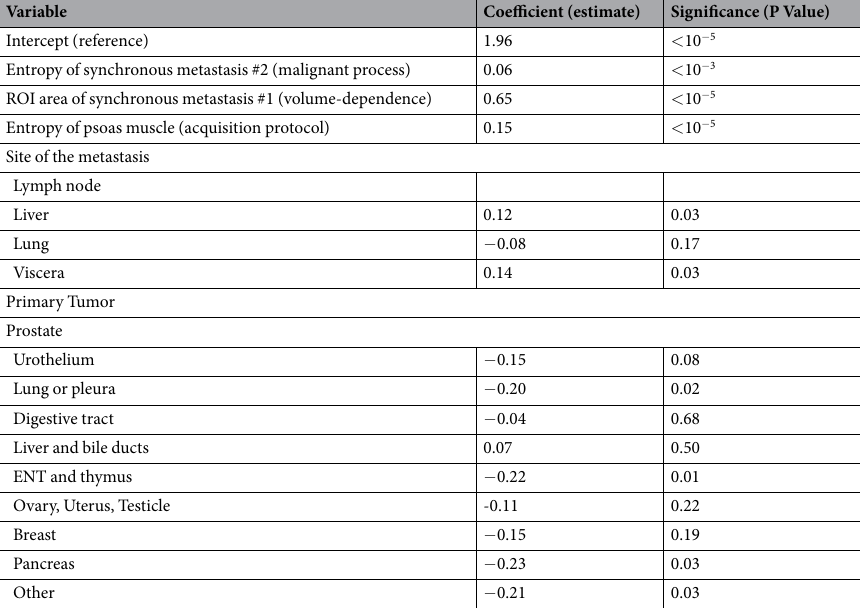
Table 1. Multivariate linear analysis of the increase of entropy in synchronous metastases #1. Multivariate linear analysis shows that entropy in SM#1 is a function of the ROI area of SM#1 (volume-dependence),